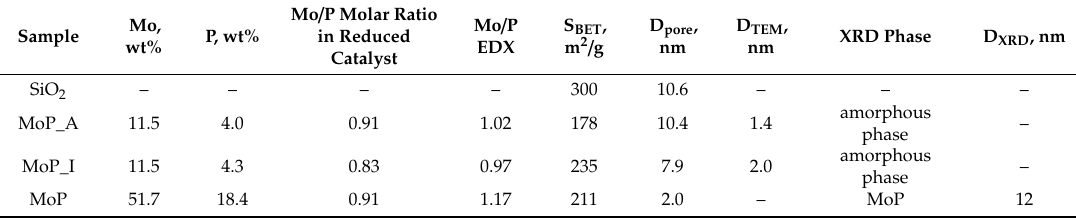
Table 1. Physicochemical properties of SiO 2 , MoP / SiO 2 and MoP